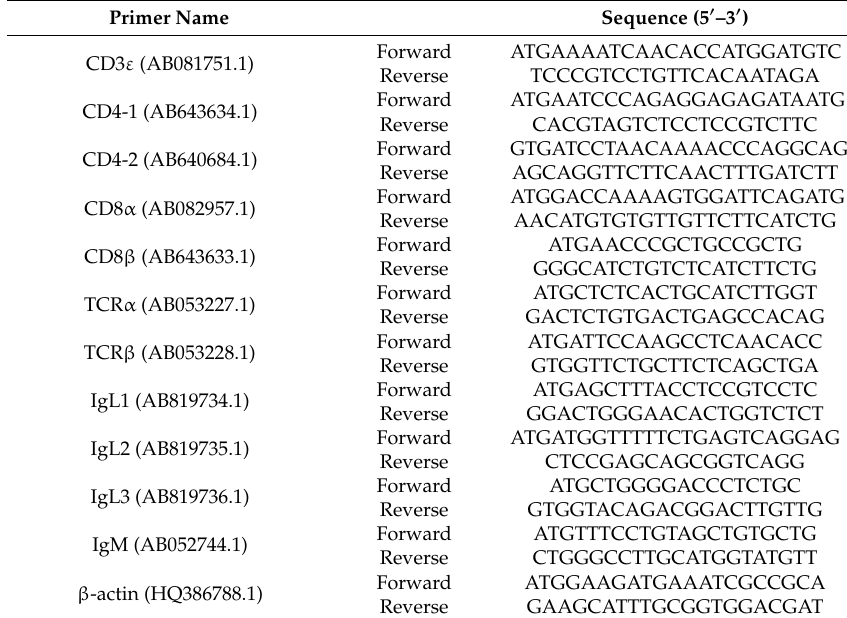
Table 1. Oligonucleotide primer sequences used for the RT-PCR